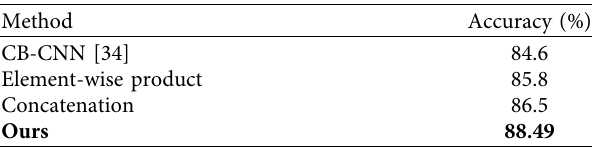
Table 3: Accuracy comparisons with different knowledge fusion